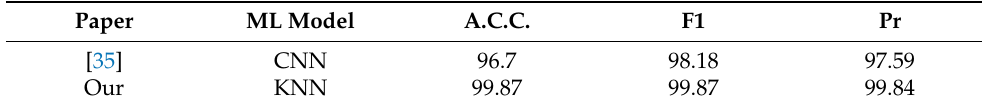
Table 7. Accuracy compared with CNN-based